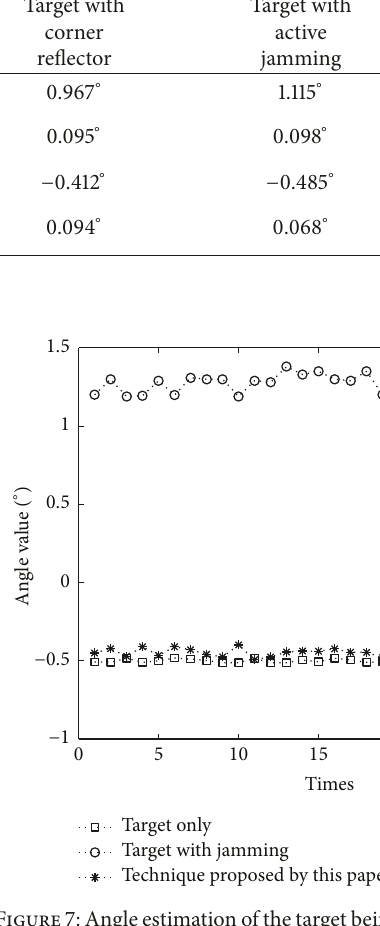
Figure 6: Angle estimation of the target being interfered with by active jamming.